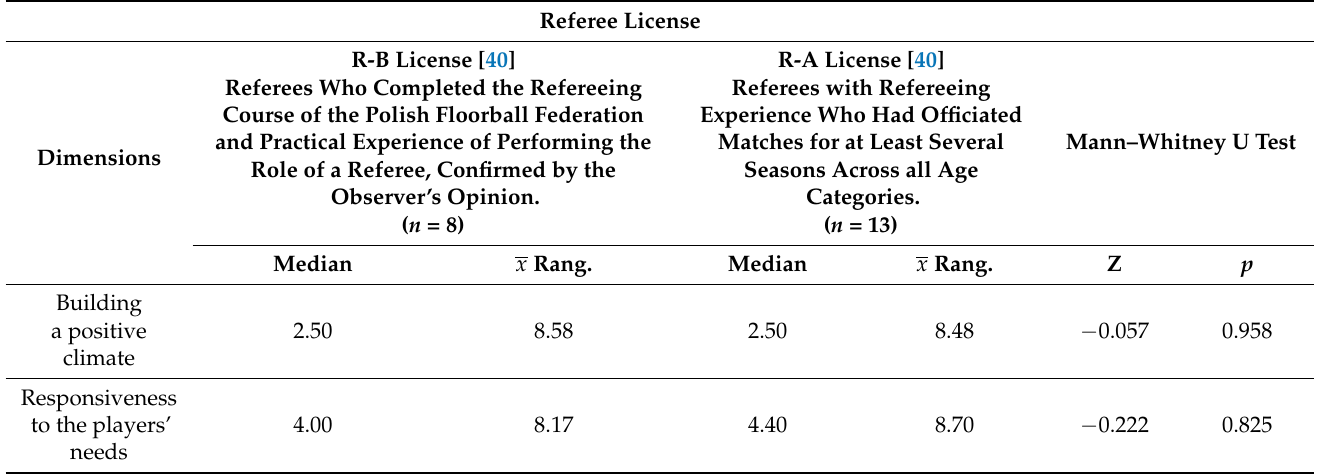
Table 4. Differences in the assessment of the quality of referee–players’ interactions in two dimensions depending on the referee license held ( n = 21).